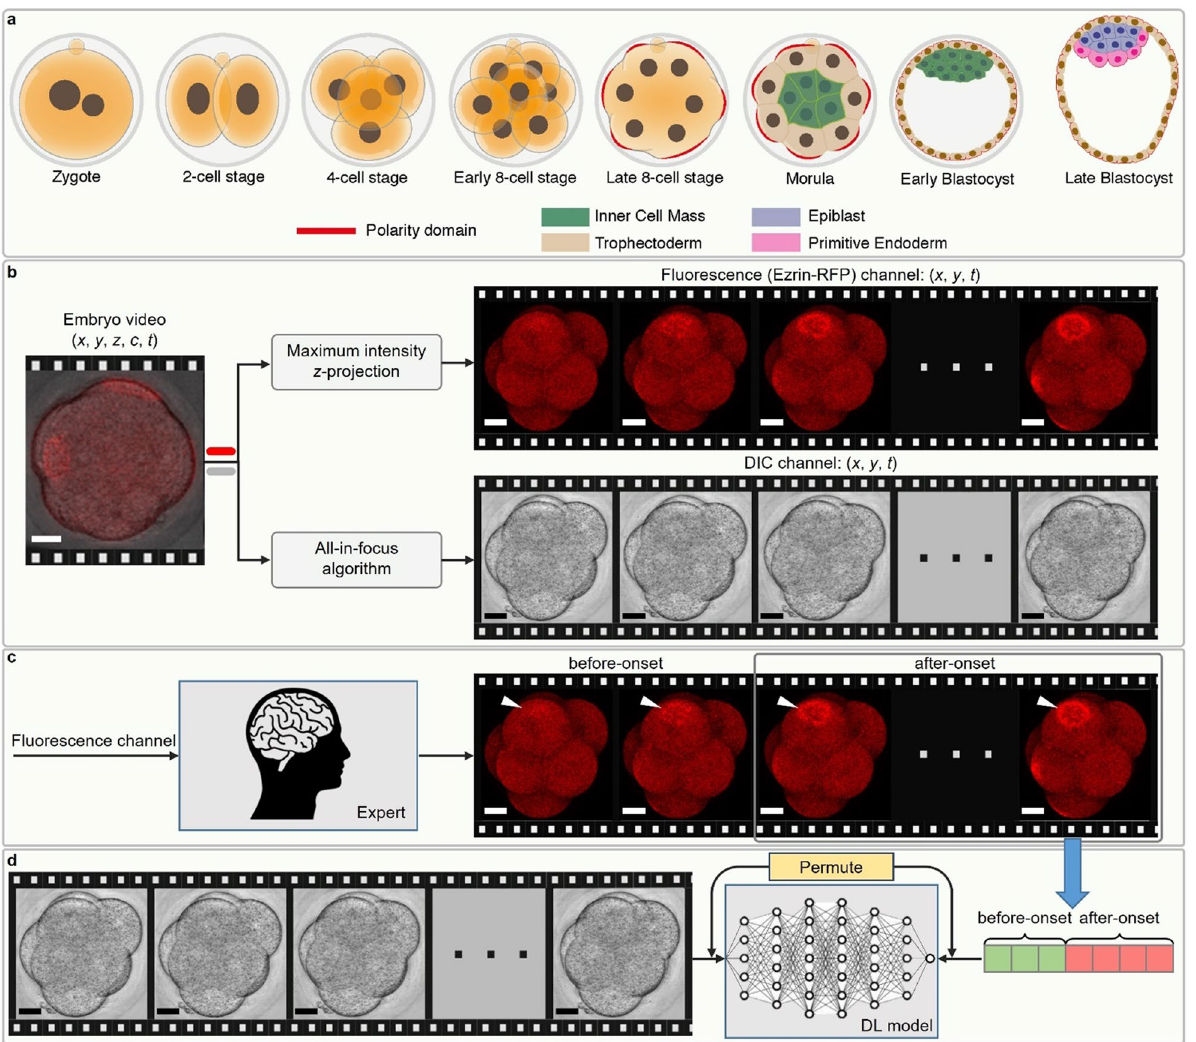
polarization takes place, as each blastomere gains a defined apical-basal axis of polarity indicated by the presence of an apical domain (red). ( b ) Data preprocessing of dual-channel 3D mouse embryo videos, each of which is a 5D tensor with the dimension of x , y , z , c (channel), and t (time). First, each video was split into a fluorescence (Ezrin-RFP) and DIC channel, visualized in red and gray respectively. Then, each channel was